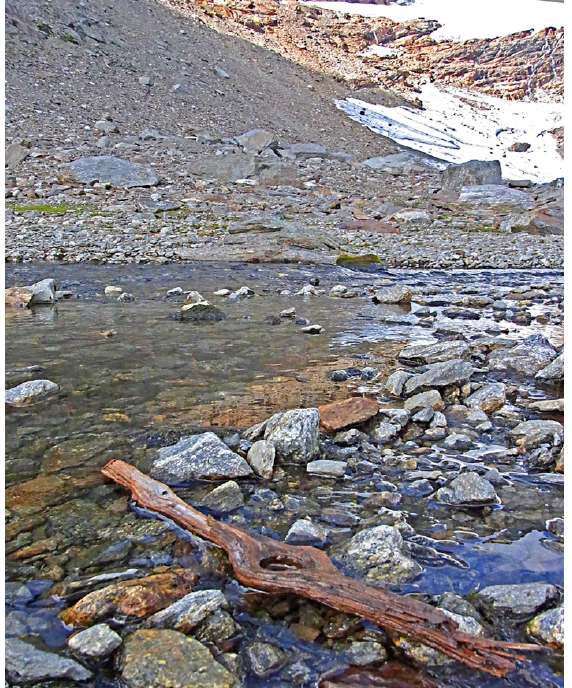
Figure 33: Tärnaglaciären (6). Piece of a small subfossil birch stem, obviously displaced to this site quite recently. 6680 cal. yr BP (Beta-268653).